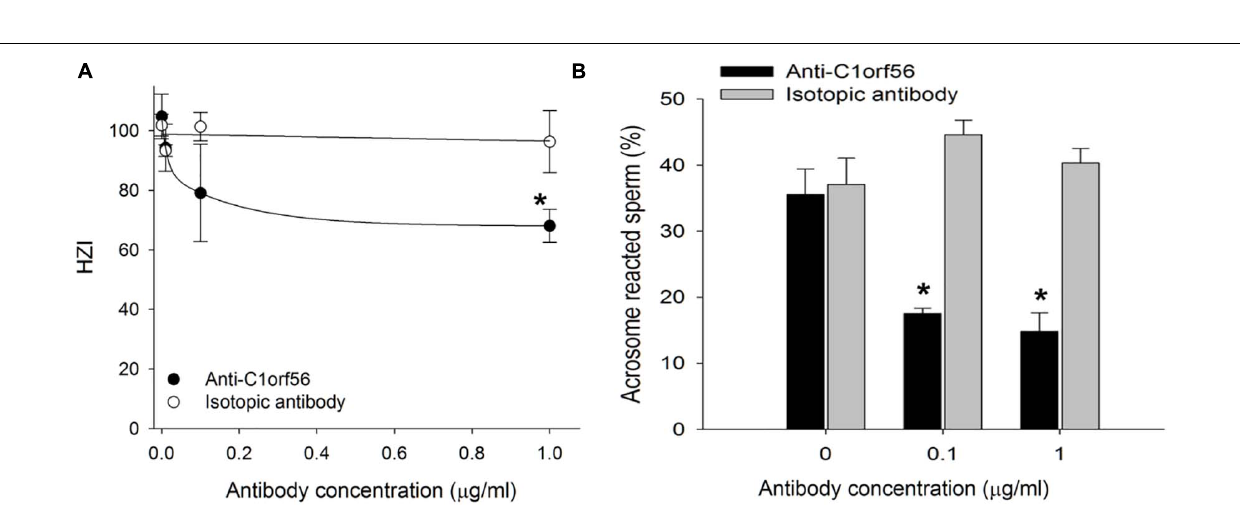
Frontiers in Cell and Developmental Biology |